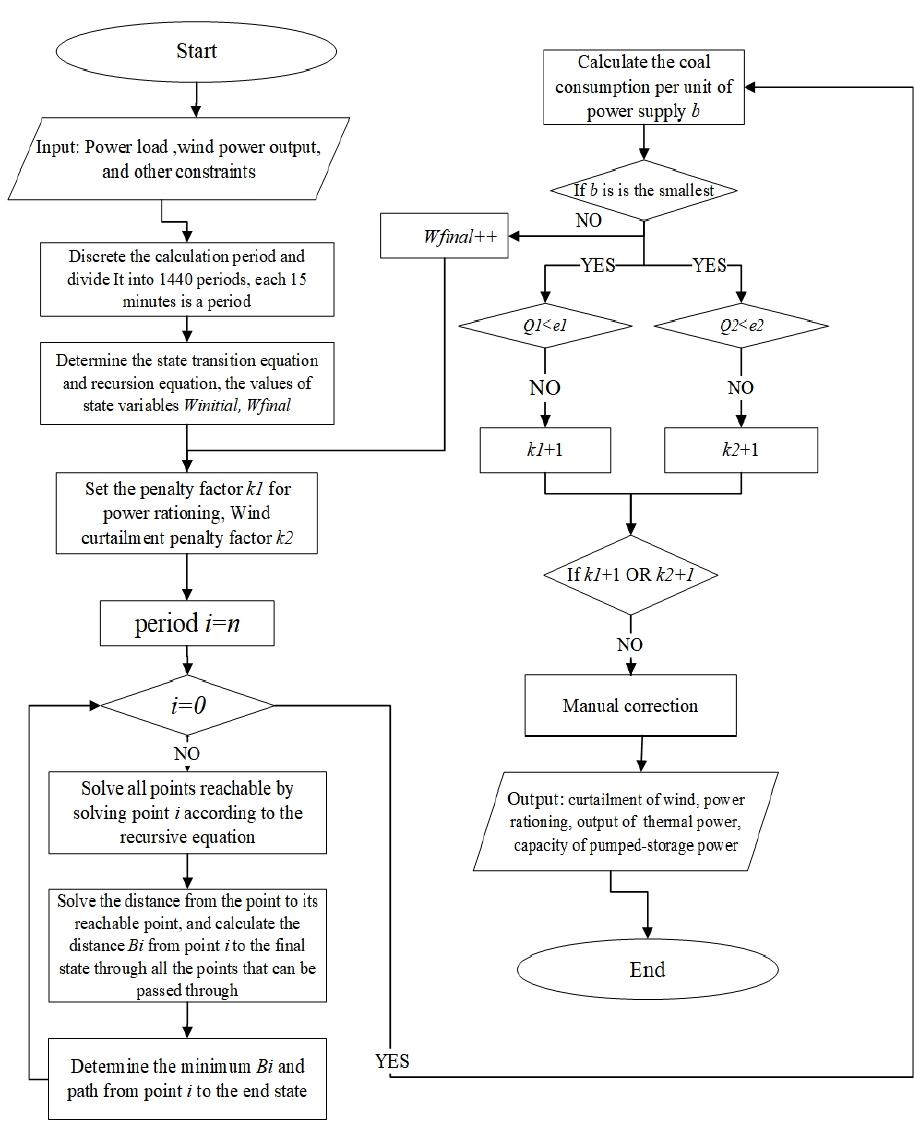
Figure 2. The steps of dynamic